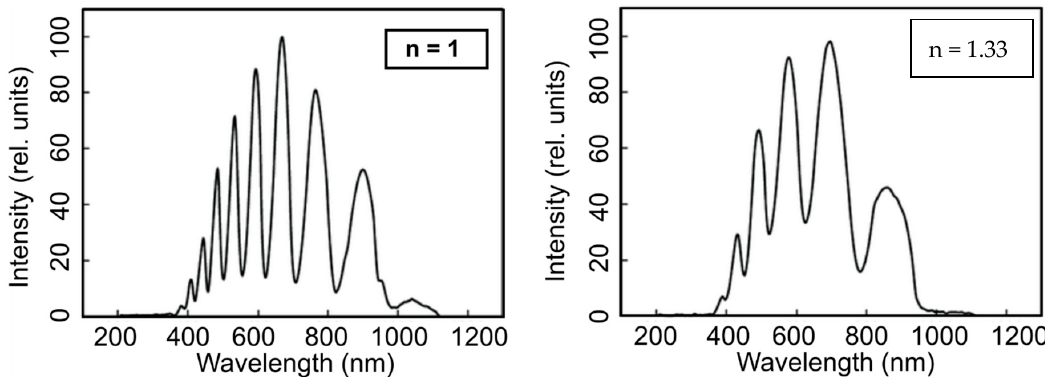
Figure 5. Transmission spectra of an empty (unfilled, n air = 1) MOF sample ( a ) and one filled with water (n water = 1.33) ( b ). Reproduced with permission from [35].